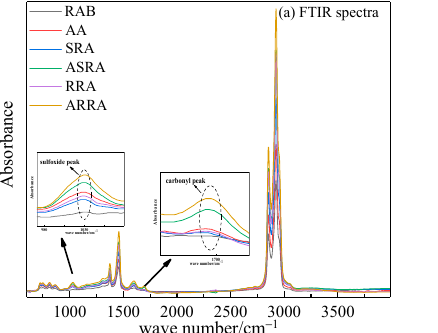
Figure 9. FTIR spectra of asphalt binders.